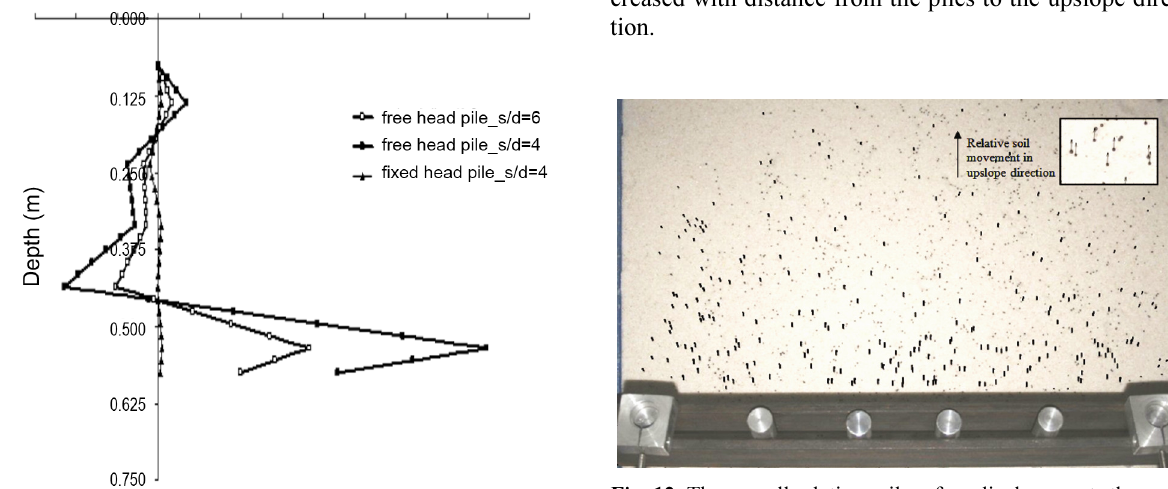
Fig. 11. Soil pressure distributions at the 18 mm box displace- ment